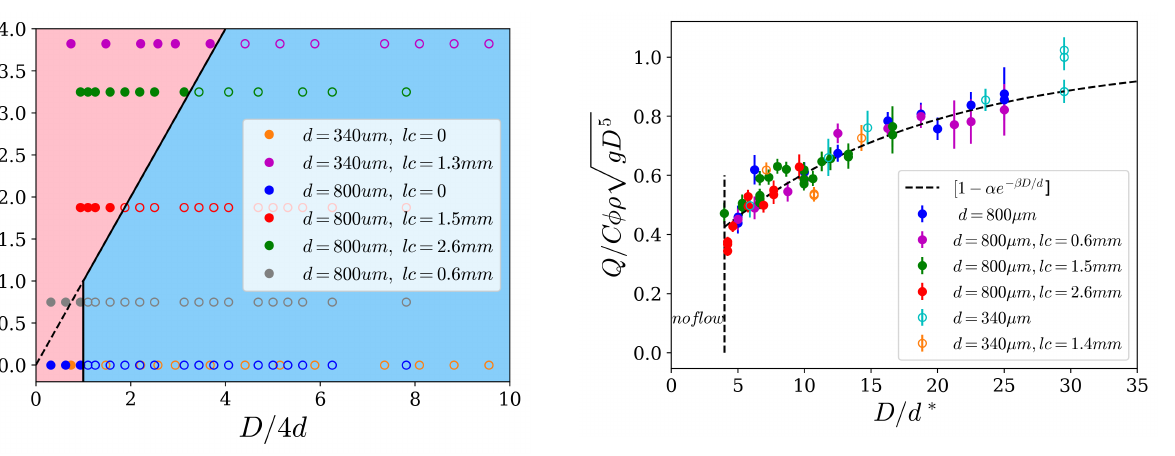
Figure 4. Rescaled mass flow rate. C = 0 . 62 , α = 0 . 74 , β = 0 . 063